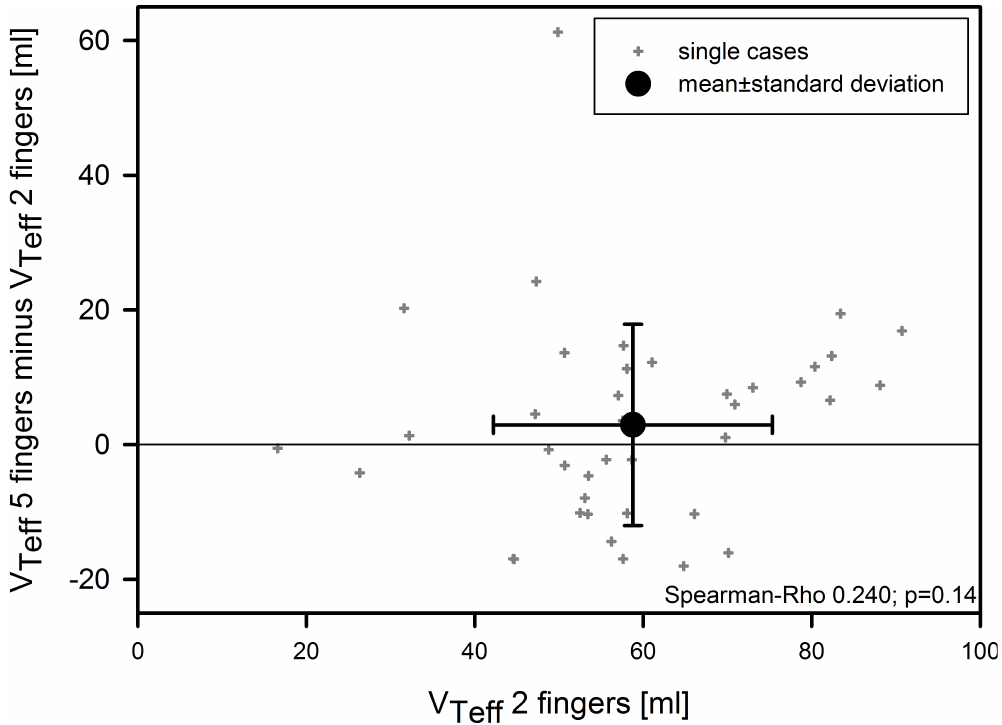
Figure 3. Comparison of effective tidal volume (V Teff ) between two-finger ventilation and five-finger